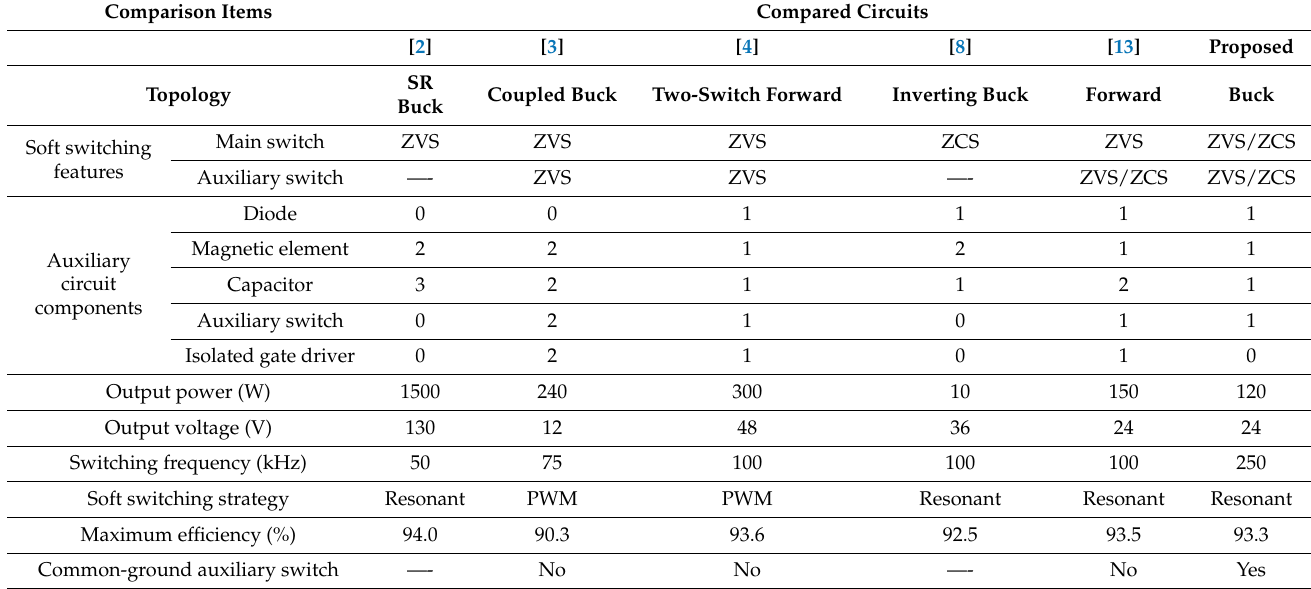
Table 2. Circuit